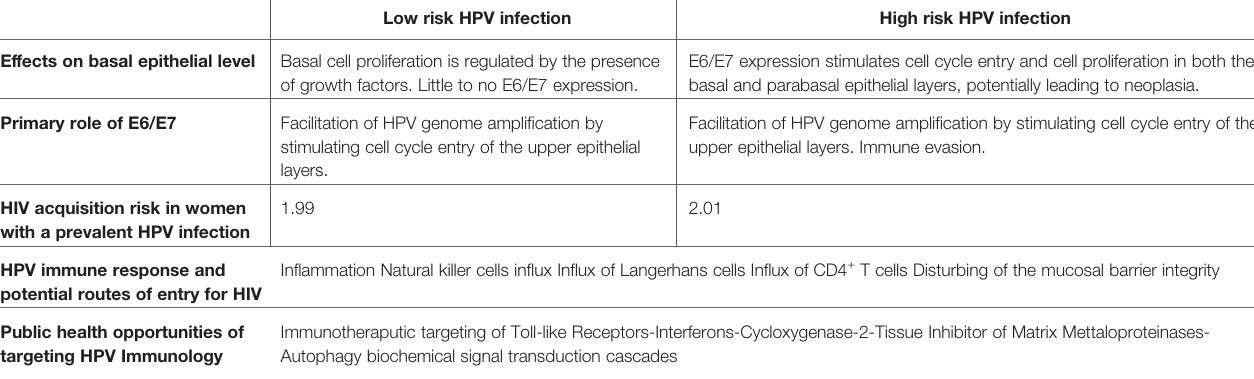
TABLE 1 | Low risk vs High risk HPV infection and HIV acquisition risk. Low risk HPV infection High risk HPV infection Effects on basal epithelial level Basal cell proliferation is regulated by the presence E6/E7 expression stimulates cell cycle entry and cell proliferation in both the of growth factors. Little to no E6/E7 expression. basal and parabasal epithelial layers, potentially leading to neoplasia.